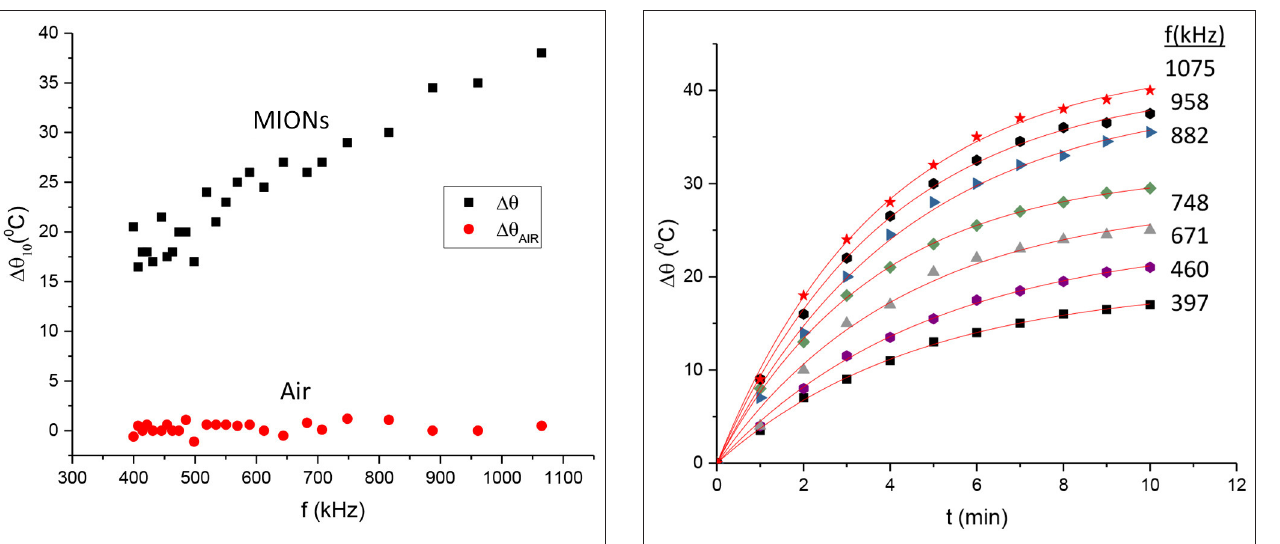
FIGURE 3 | Temperature change. 1θ 10 = θ (10) − θ (0) between the final and the initial temperatures for the 10-min interval vs. frequency. Top dataset: MIONs solution. Bottom dataset: Air inside the coil.